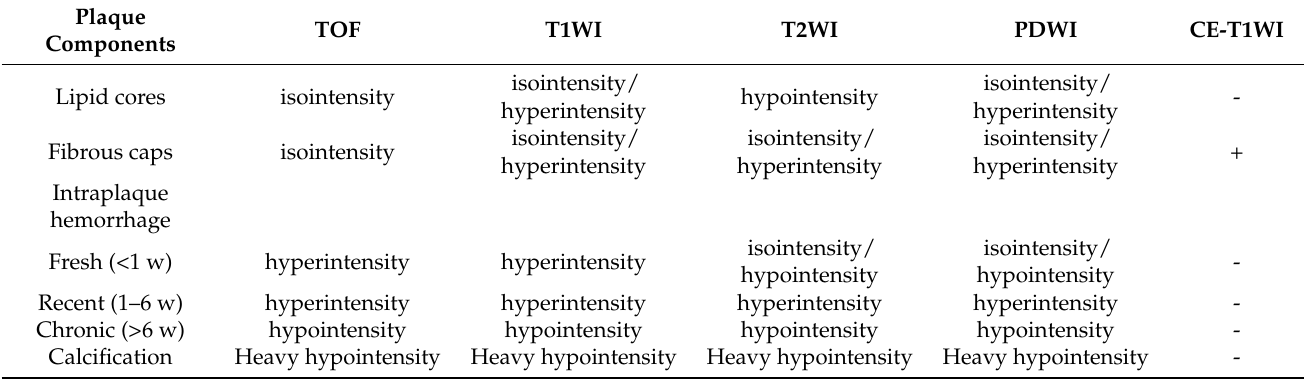
Table 1. Plaque components